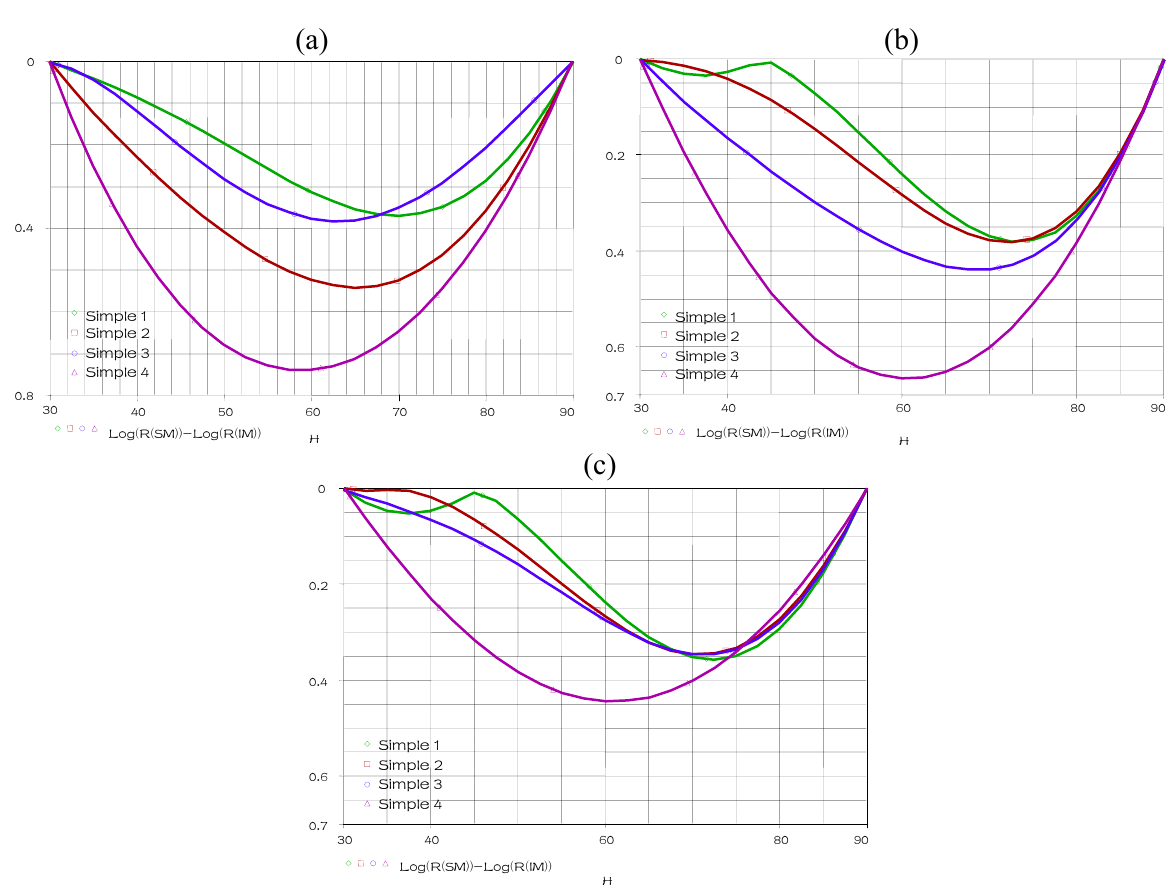
Figure 9. Parametric SWEEP analysis for samples 1–4, at fixed temperature (a) 15